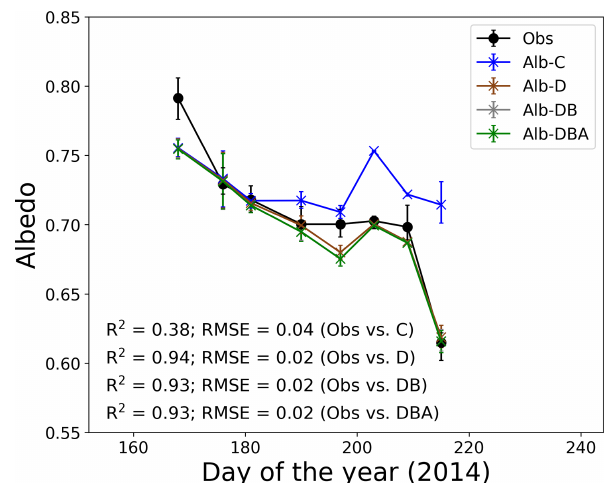
Figure 4. Temporal changes in observed and calculated snow albedo at the study site. Solid symbols indicate observed snow albedo. Cross symbols indicate four simulations of snow albedo based on the assumption of snow impurity inclusions. Error bars indicate the albedo range simulated using the meteorological con- ditions at 10:00, 11:00 and